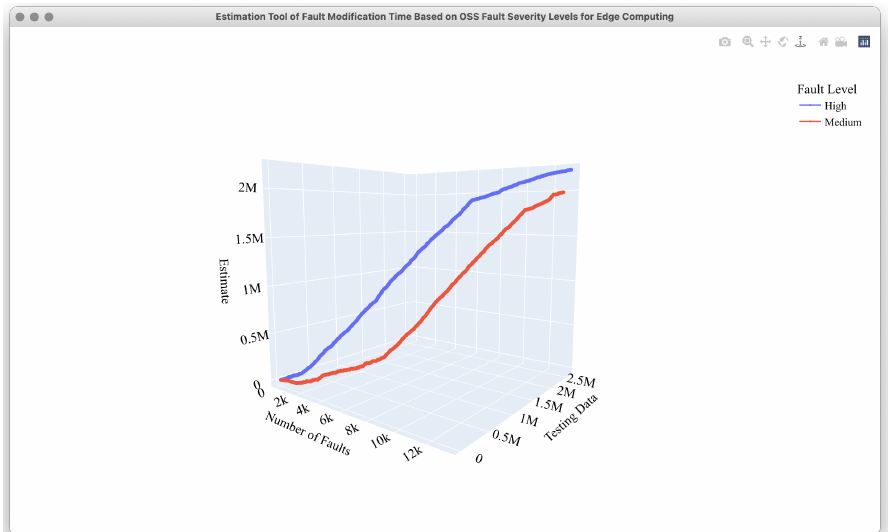
Figure 18. Another angle of the estimated cumulative fault correction time in case of 30% testing data.